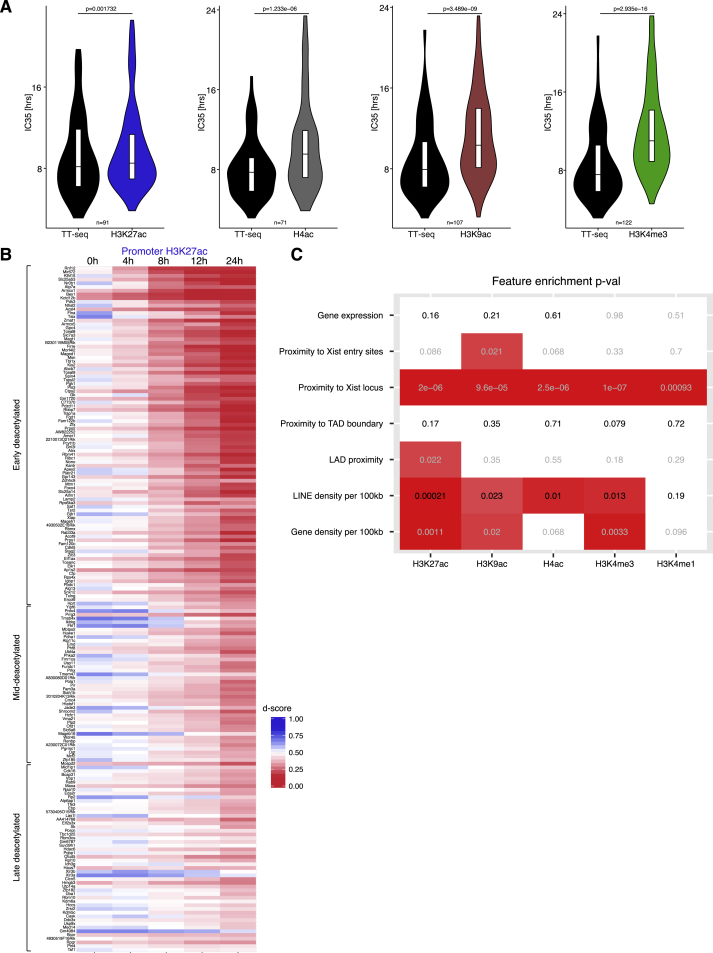
Histone Deacetylation Correlates with Transcriptional Silencing and Some Genomic Features, Related to Figure 2(A) Violin plots comparing the dynamics of transcriptional silencing and the loss of active histone modifications from associated promoters. Plots compare the IC35 parameter calculated from TT-seq nascent transcription profiling to the IC35 of different active histone marks (H3K27ac, H4ac, H3K9ac, H3K4me3). p values were calculated using paired Wilcoxon rank sum test. (B) Heatmap of H3K27ac allelic dynamics at all promoters clustered using k-means. (C) An array showing features enriched (gray font) or depleted (black font) at promoters efficiently inactivated (low IC35) compared to late inactivated (higher IC35) using a panel of histone modifications. Shown are p values calculated using Wilcoxon rank sum test with Benjamini Hochberg correction. Red cells are reaching statistical significance of p < 0.05.